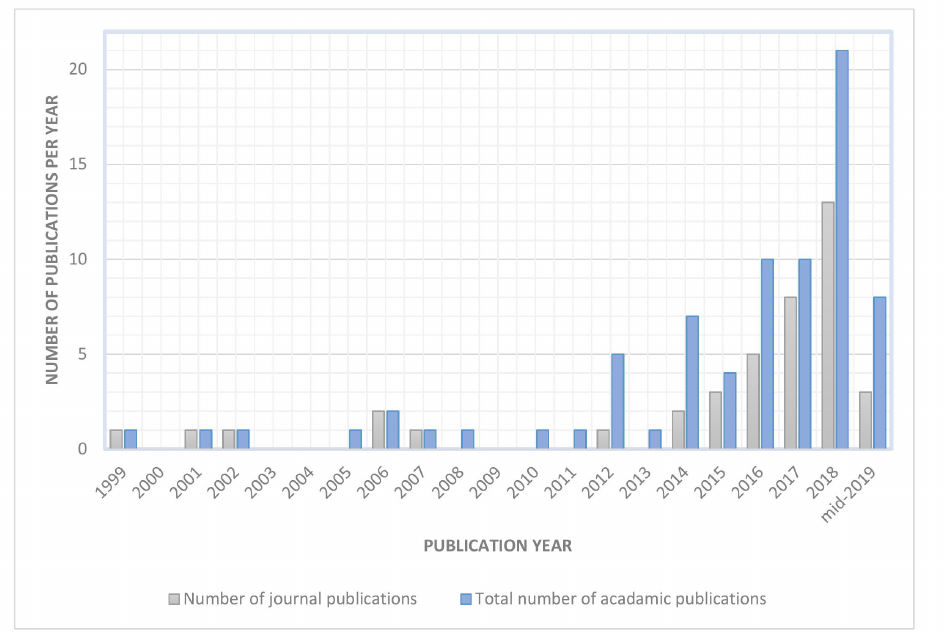
Figure 1. Number of FMG related publications from 1999 to mid-2019 ( n = 76). The grey bar shows the number of journal publications and the blue bar shows the total number of FMG related publications which includes the journal, conference, and workshop proceeding